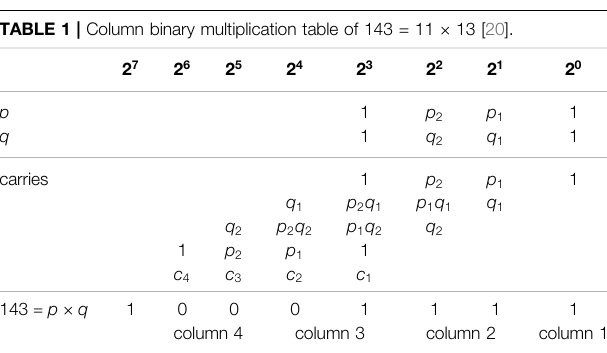
TABLE 1 | Column binary multiplication table of 143 = 11 × 13